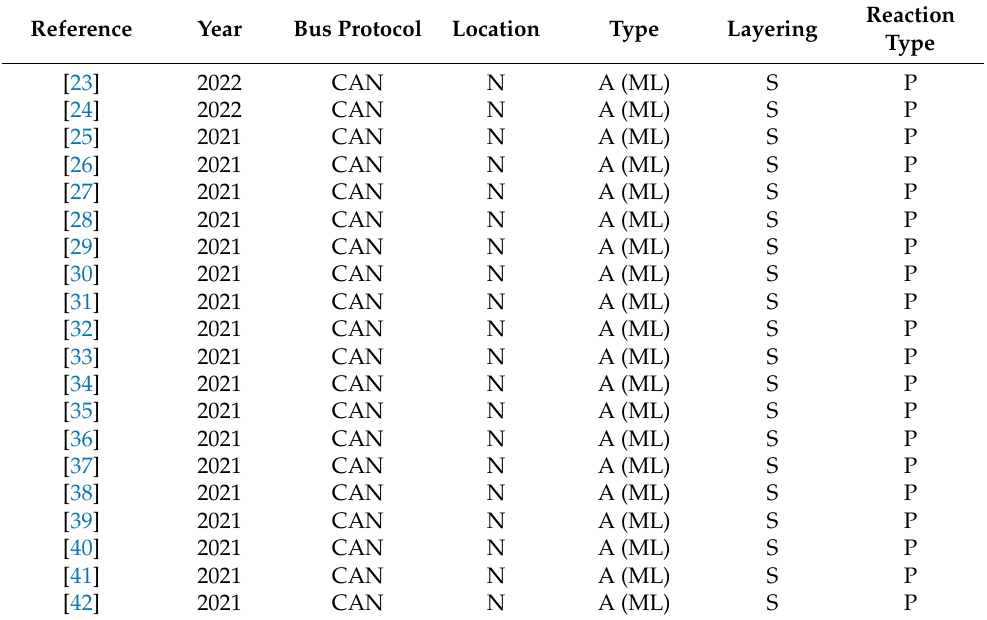
Table 2. IDS approaches for IVN between 2020 and 2022. N: NIDS, H: HIDS, A: anomaly-based, ML: machine learning, PC: physical characteristics, S: single, C: cross, P: passive.